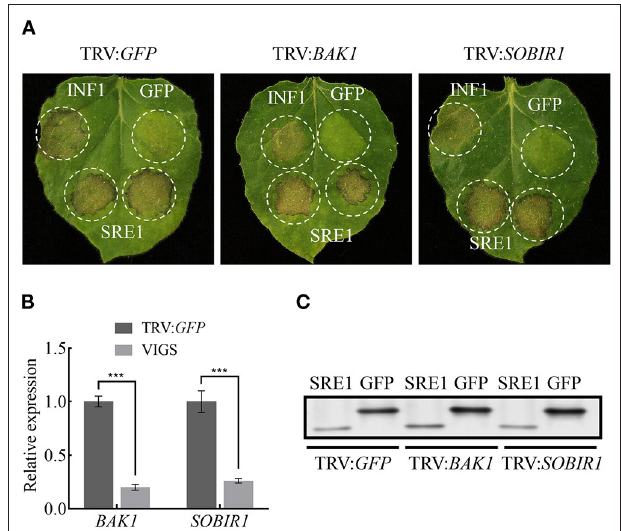
FIGURE 4 | SRE1-induced cell death is BAK1/SOBIR1-independent. (A) The TRV-mediated gene silencing system was used to verify that SRE1-induced cell death is independent of BAK1/SOBIR1. INF1 and GFP were positive and negative controls, respectively. (B) Expression levels of BAK1 and SOBIR1 after silencing were detected by qPCR. The Student’s t -test was carried out to determine the significance of the difference. Error bars indicate the standard deviations of three biological replicates. ***Indicates a significant difference at a P -value of < 0.001. (C) Western blot analysis of proteins expressed in silenced N. benthamiana